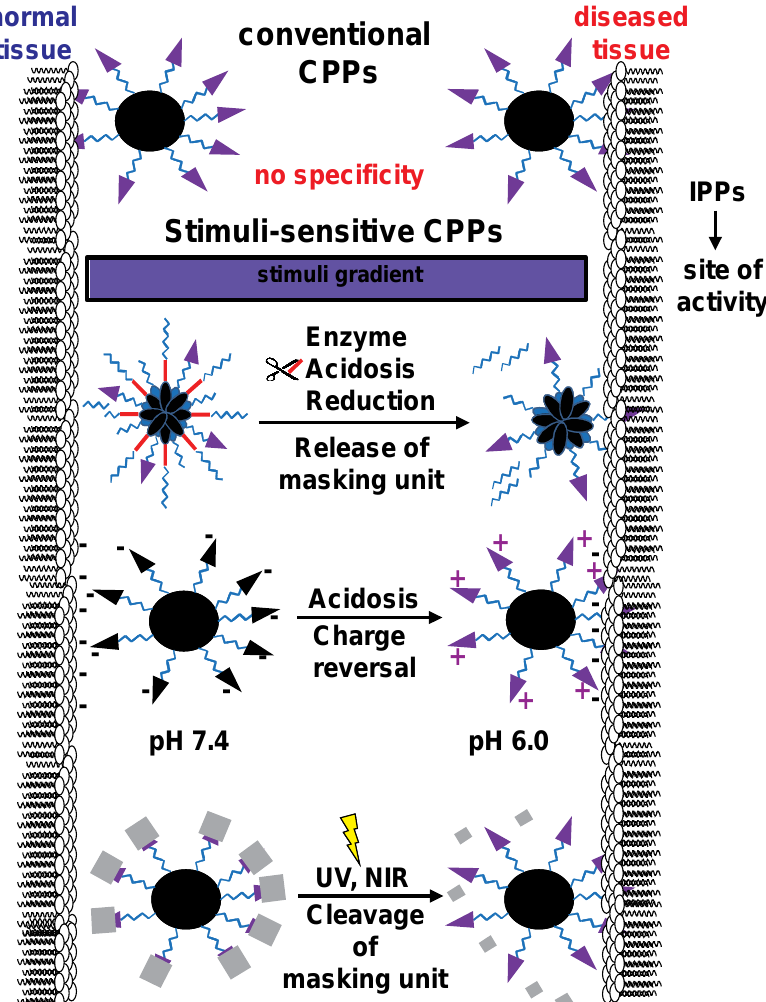
Figure 1. Strategies of CPP conjugation to nanocarriers. Conventional CPP coupling unselectively increases nanocarrier’s endocytosis both by normal and diseased tissues. Oppositely, stimuli-sensitive CPPs display higher selectivity as CPPs are hold in a scabbard until activation by a threshold concentration of stimuli thereby decreasing non-specific endocytosis.